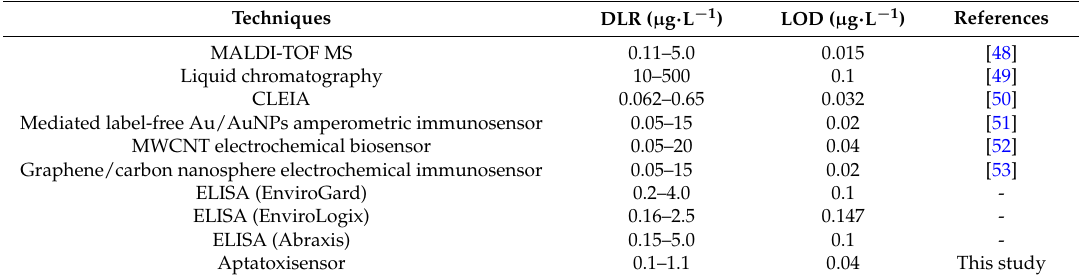
Table 3. Comparison of the aptatoxisensor with similar electrochemical sensors and selected analytical techniques used in the screening of